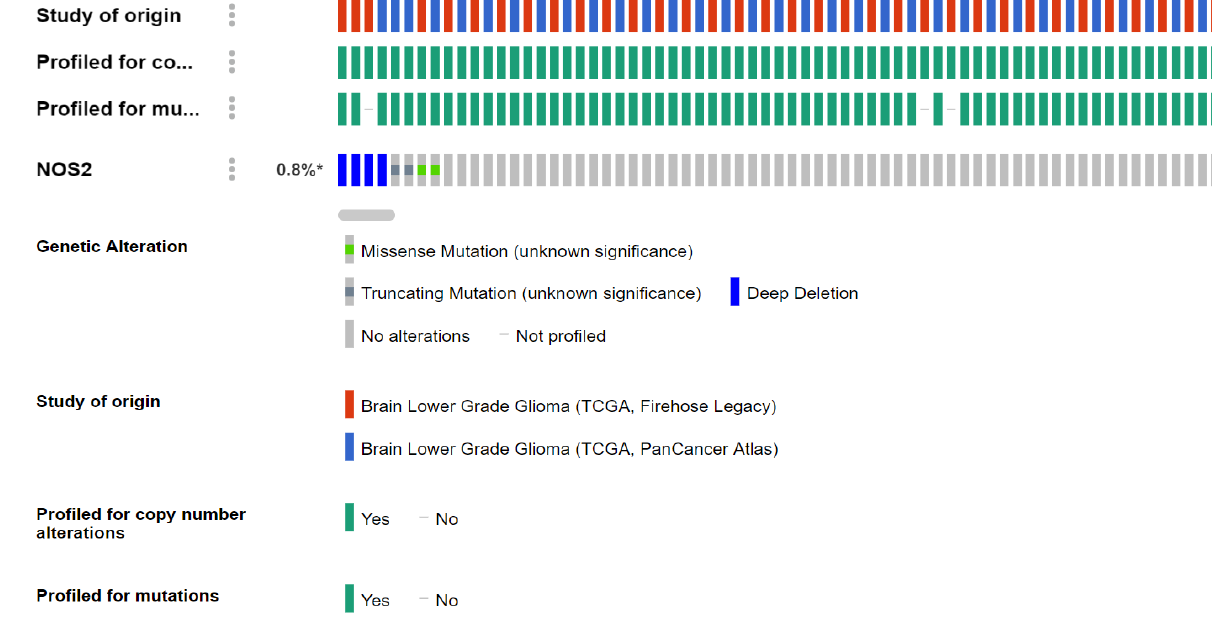
Figure 4: iNOS/NOS2 mutation analysis using TCGA databases and the online analysis tool